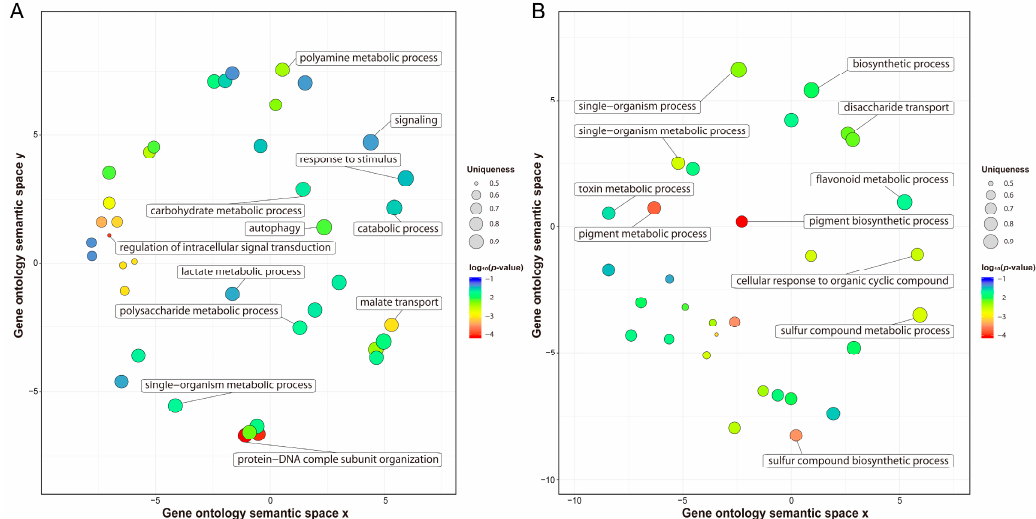
Figure 4. Nonredundant GO-terms related to biological processes obtained by enrichment analysis of the upregulated genes in H559 ( A ) and YM21 ( B ) before cold stress. The REVIGO program was used to de-redundant the significant GO-terms, and bubble charts were then drawn by using the R package to display the nonredundant GO-terms. Nonredundant GO-terms were clustered on a two-dimensional space according to the semantic similarity between them (adjacent bubbles are most closely connected). Bubble size is proportional to the uniqueness value of each GO-term, and the color represents the log 10 ( p -value).